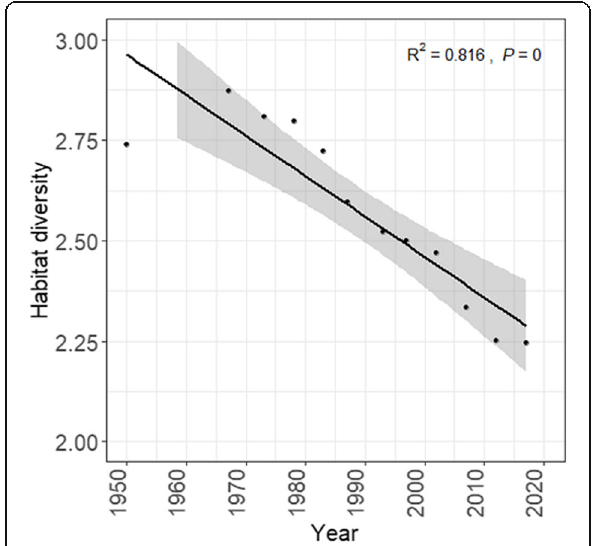
Fig. 3 Shannon-Wiener ’ s index of diversity based on the 25 vegetation zones originally mapped in Amboseli in 1967 and transposed onto 1950 aerial photos